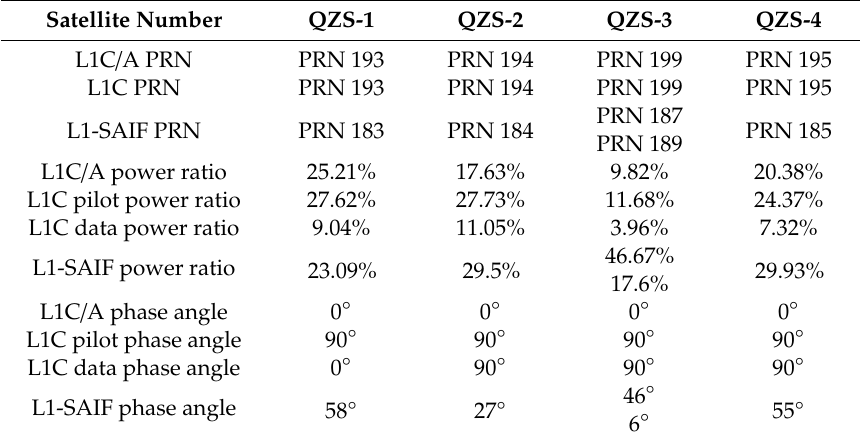
Table 2. QZSS satellite L1 frequency signals composition analysis.